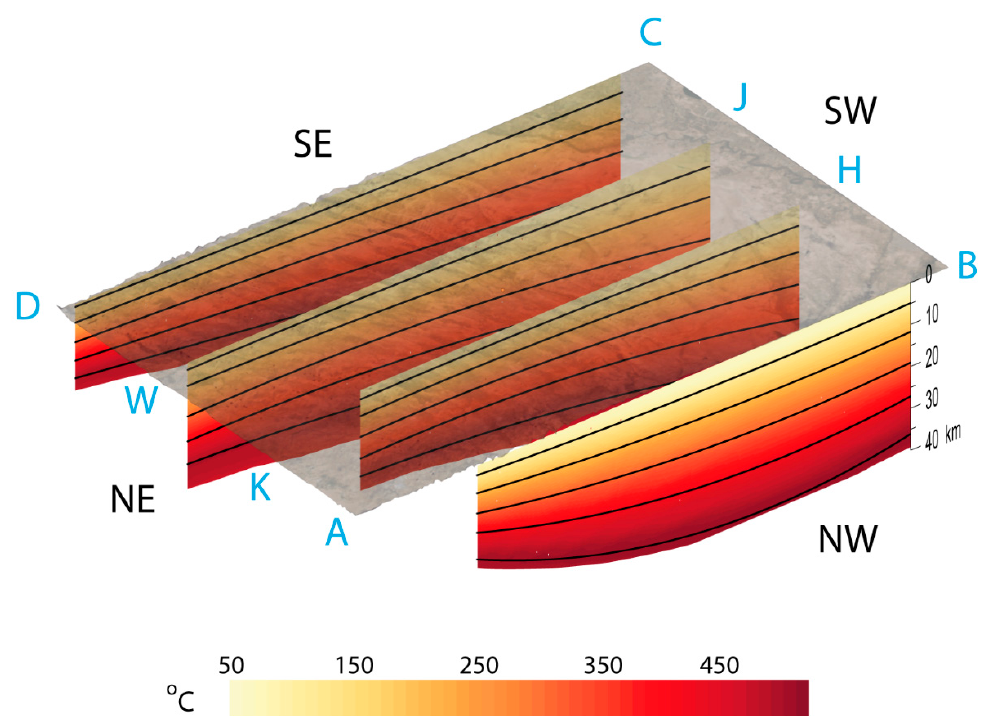
Figure 11. Thermal structure of the Lurestan arc as defined by isotherms calculated using a second-order power-law polynomial interpolation along cross-sections AB, KH, WJ, and DC (located in Figure 5, black lines are 100, 200, 300, 400, and 500 ◦ C isotherms). Surface topography is from the 30-m resolution ASTER GDEM.